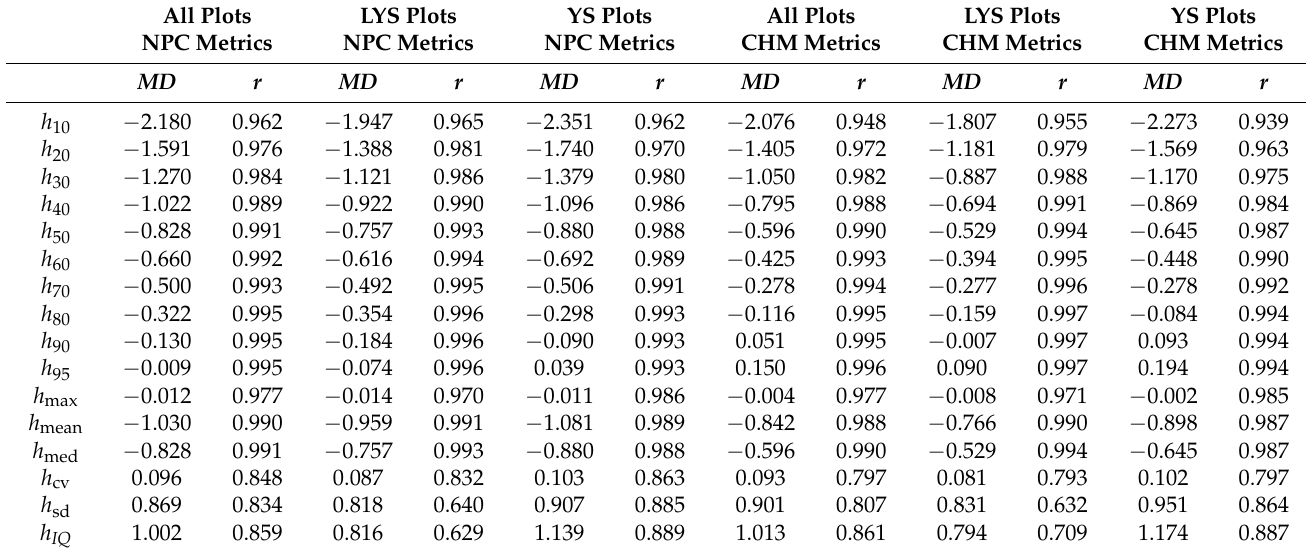
Table A1. Comparison of metrics from normalized point clouds and CHM.